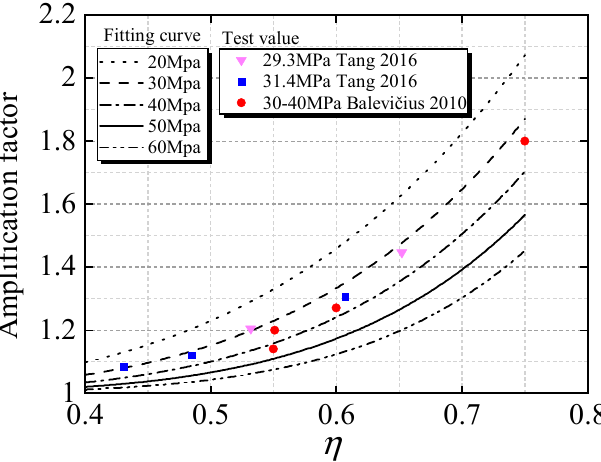
Figure 9. Comparative analysis of amplification factor compared with Tang [21] and Baleviˇcius [42].